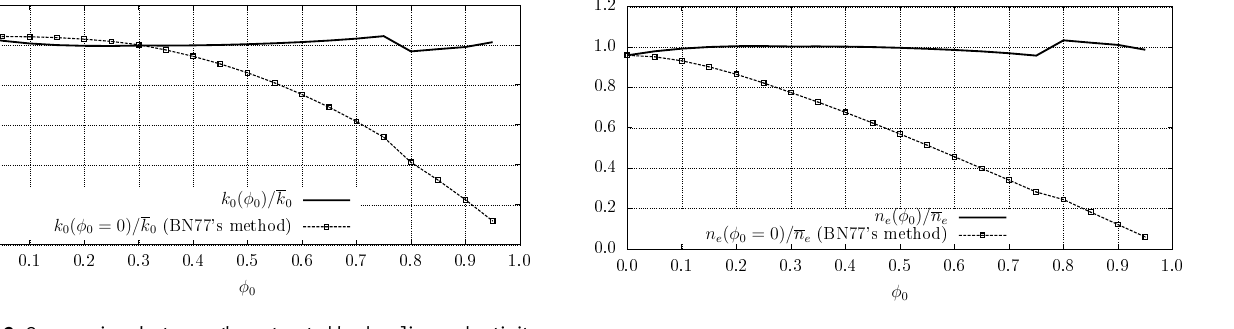
Figure 3. Comparison between the drainable porosity n e as esti- mated by the original BN77 analysis (dotted line and symbols) and the method proposed here (solid line) – both normalized by the real value n e used to numerically generate the discharge data and vary- ing against the normalized water height at the origin φ 0